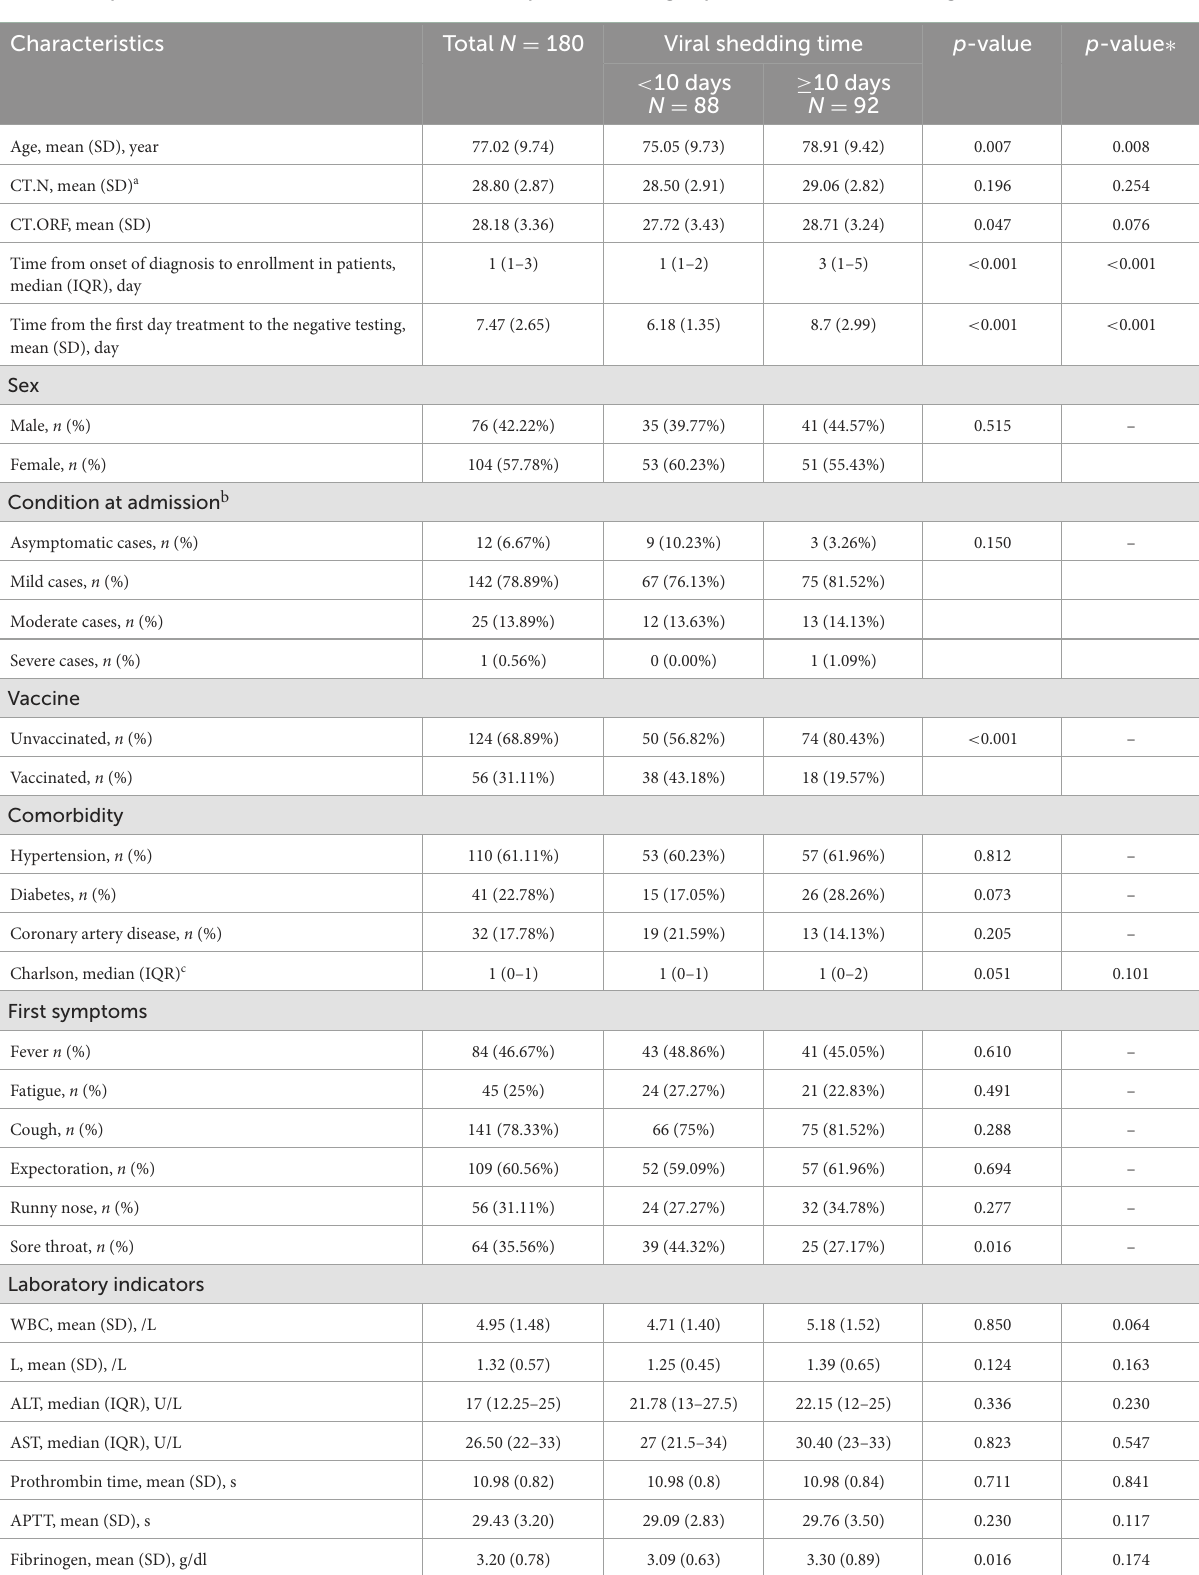
TABLE 1 Comparison of clinical characteristics and treatment responses between groups with different viral shedding time.